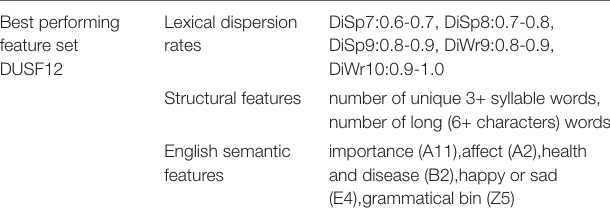
TABLE 4 | The best-performing feature set DUSF12. Best performing feature